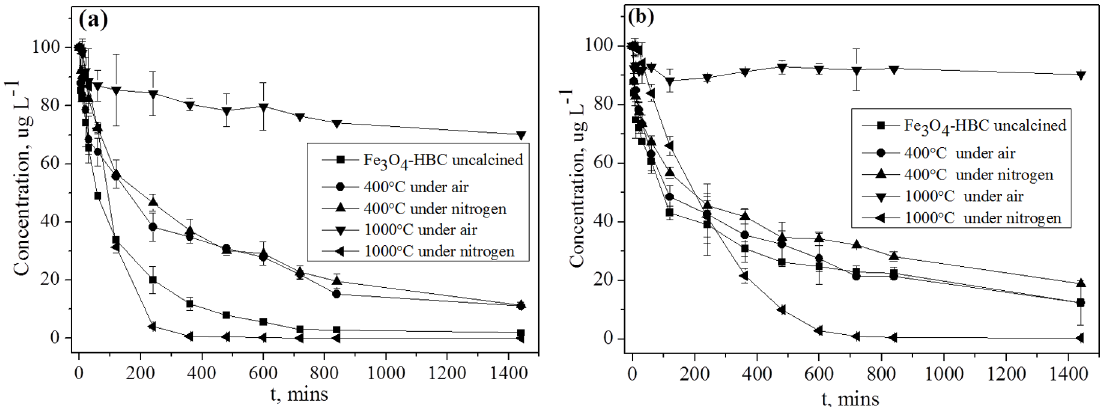
Figure 5. The effect of contact time on the removal of As(V) (a) and As(III) (b) by the uncalcined and calcined Fe 3 O 4 -HBC composite (Experiment conditions: adsorbent dose =0.02 g 100 mL 2 1 , temperature =25 ± 0.8 6 C, agitation speed =150 rpm, initial concentration =100 m g L 2 1 , contact time =14 h).